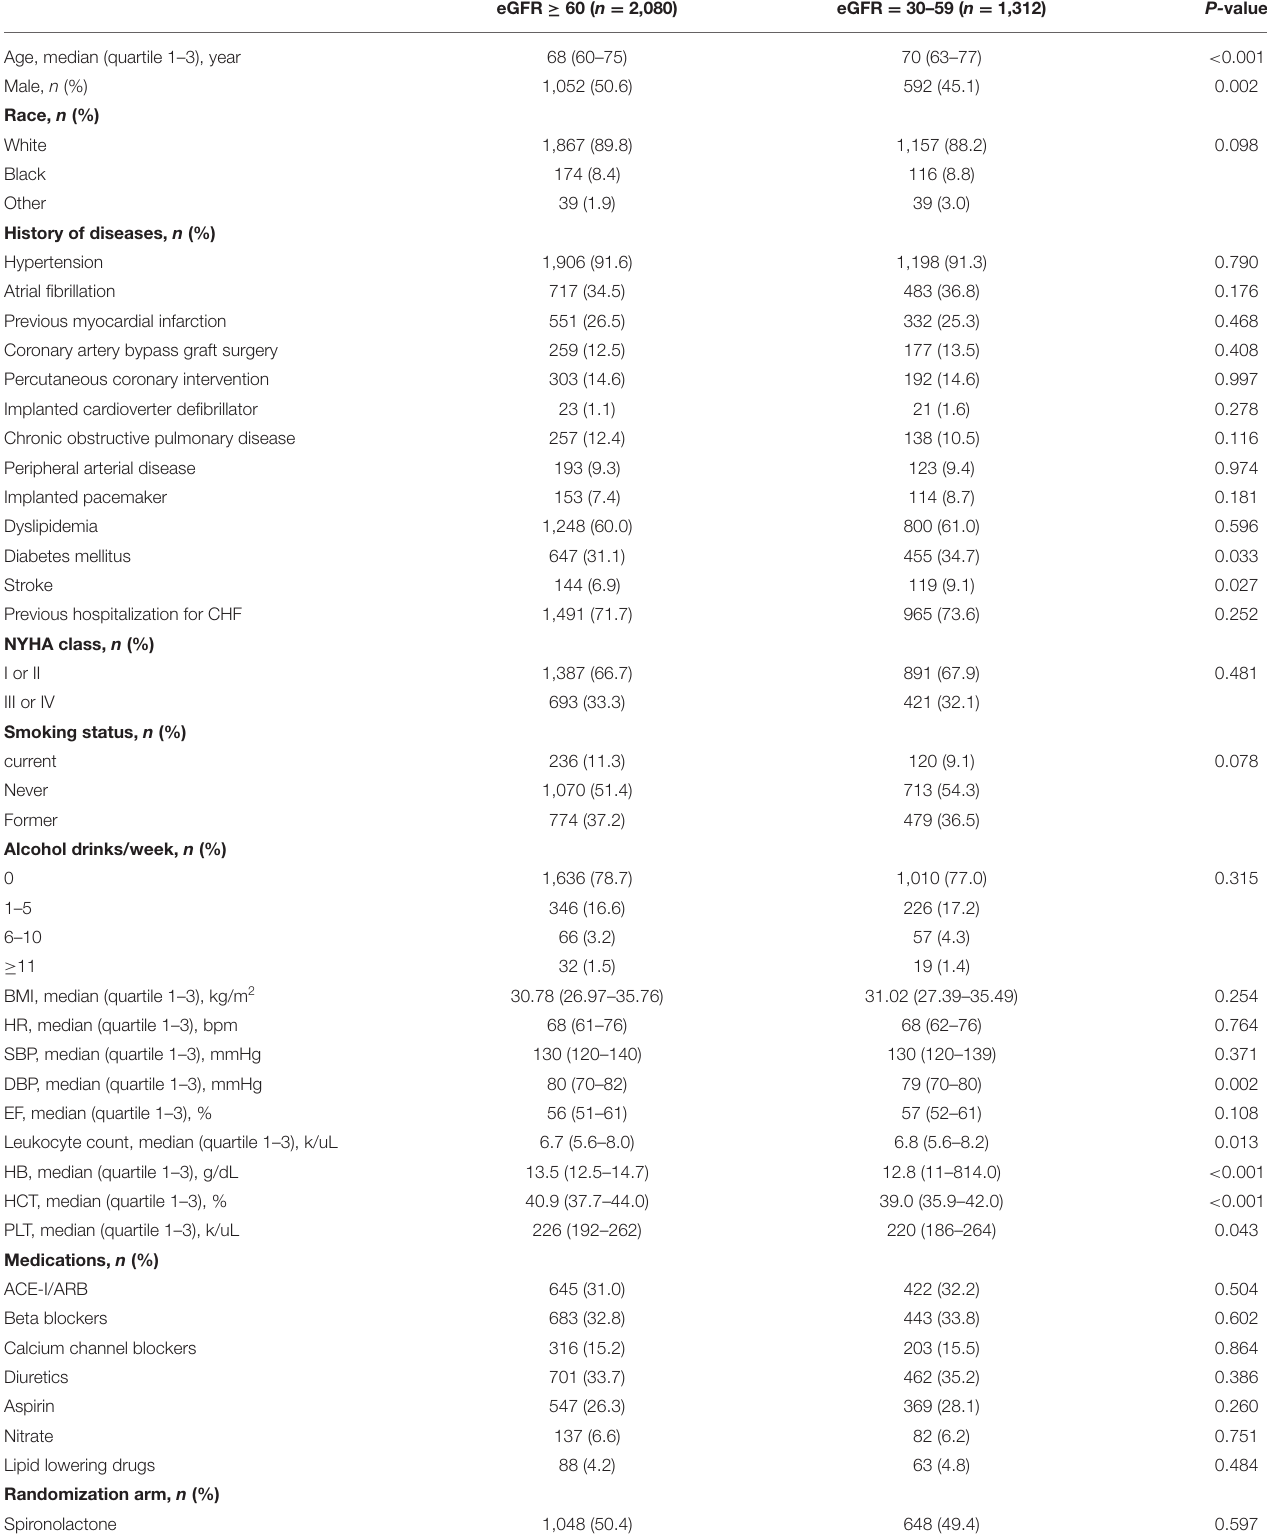
TABLE 1 | Baseline clinical characteristics of HFpEF patients with and without renal